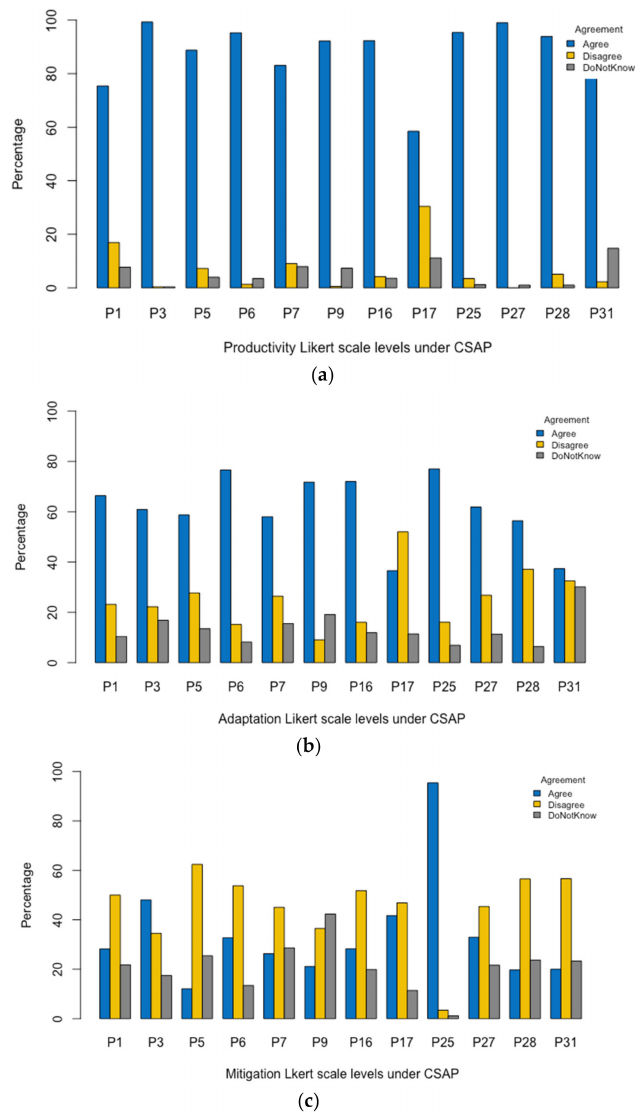
Figure 3. Frequency of Likert scale levels of agreement with the statement that Climate-Smart Agriculture Practices (CSAPs) contribute to CSA’s pillars: ( a ) Productivity and income; ( b ) Adaptation; ( c )